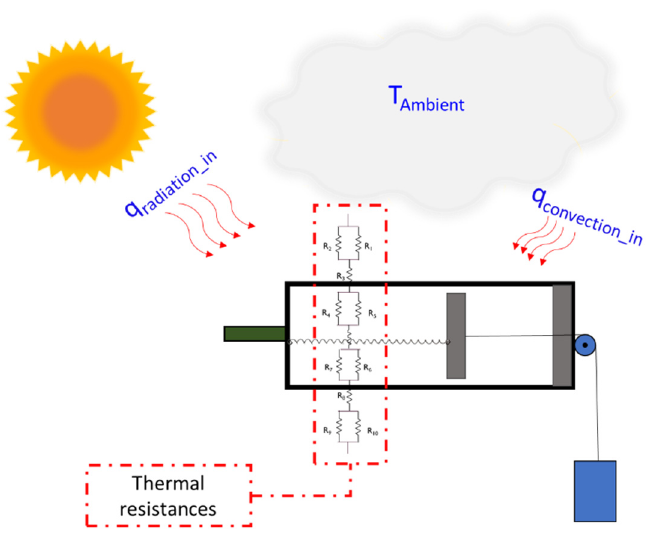
Figure 17. Overview of a 1D thermal model.